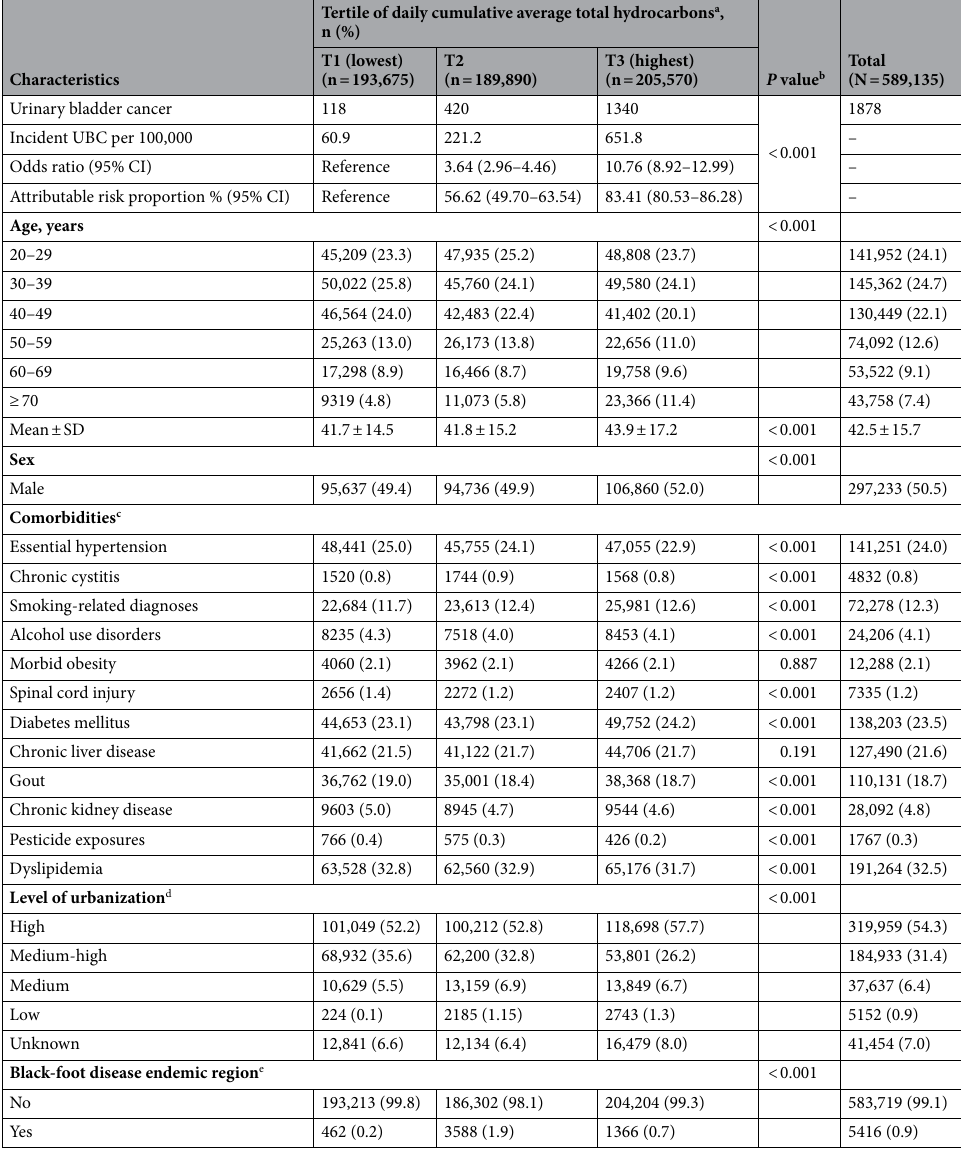
Table 1. Odds ratios of incident urinary bladder cancer by tertile of the total hydrocarbons’ exposure and characteristics of the cohorts. CI confidence interval, SD standard deviation, UBC urinary bladder cancer. a The tertile values, in ppm, are as follows: T1: < 2.17, T2: ≥ 2.17 and < 2.32, and T3: ≥ 2.32. b The Chi-squared test